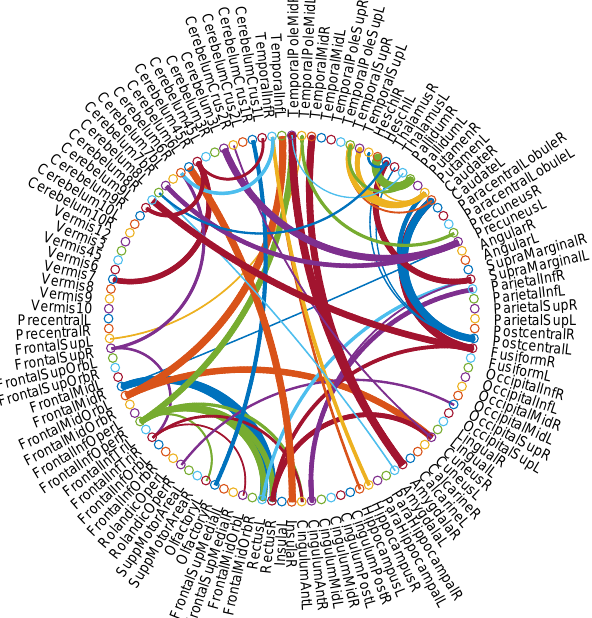
Figure 5. The most discriminative features detected by the proposed method in ASD vs. NC classification based on an AAL template. This figure was created using circularGraphtool (http://www.mathworks.com/matlabcentral/fileexchange/48576-circulargraph (accessed on 10 October